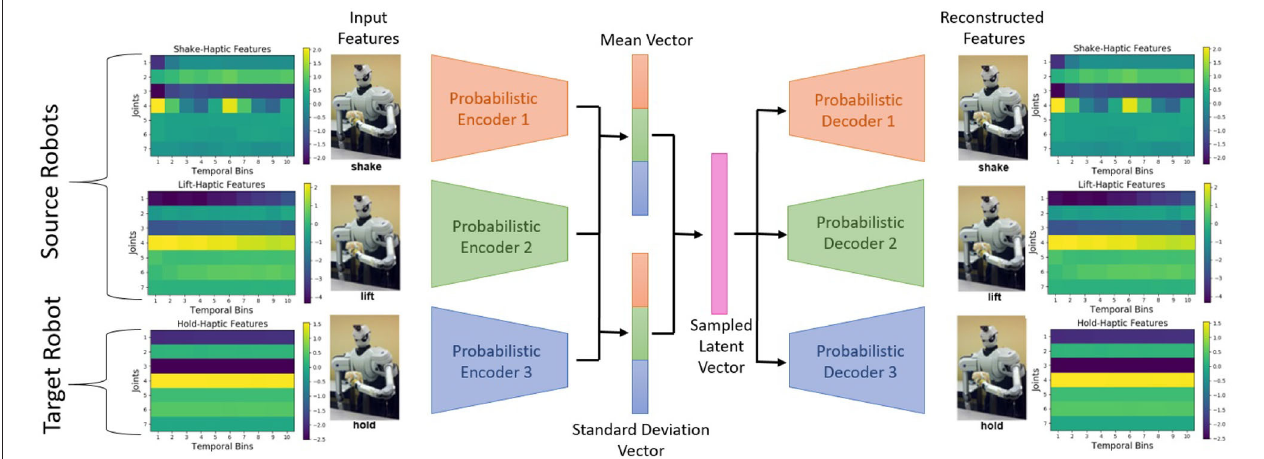
FIGURE 2 | The proposed β -VAE network architecture. In this example, the network is trained to reconstruct data points from the hold-haptic context given data points from the shake-haptic and lift-haptic